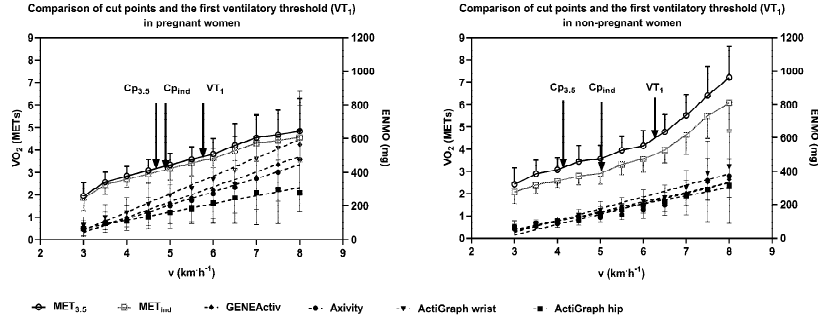
Figure 1. Mean ± SD oxygen uptake (VO 2 ) expressed in MET 3.5 (1 MET = 3.5 mL/kg×min) and MET ind (1 MET = 3.7 ± 0.5/4.2 ± 0.6 mL/kg×min in pregnant/nonpregnant women) as well as the Euclidian norm minus one (ENMO= √ (a x2 +a y2 +a z2 ) ‐ 1g) from GENEActiv, Axivity, ActiGraph wrist and hip for each single load step of the incremental walking test (IWT). Arrows mark cut point values determined